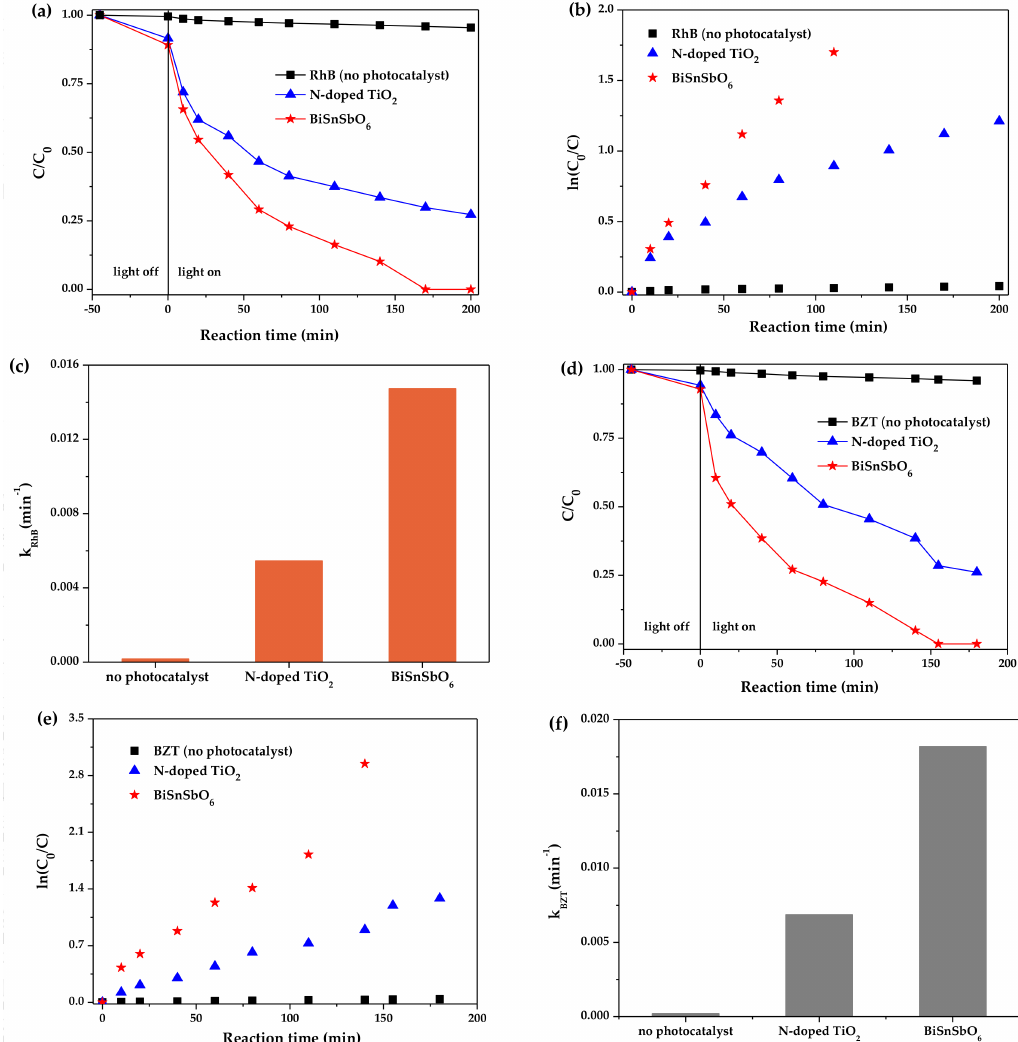
Figure 6. ( a ) Degradation curves of RhB over different samples; ( b ) Linear relation plots of ln(C 0 /C) vs. reaction time; ( c ) The photodegradation rate constants ( k ) calculated from ( b ); ( d ) Degradation curves of BZT over different samples; ( e ) Linear relation plots of ln(C 0 /C) vs. reaction time; ( f ) The photodegradation rate constants ( k ) calculated from ( e